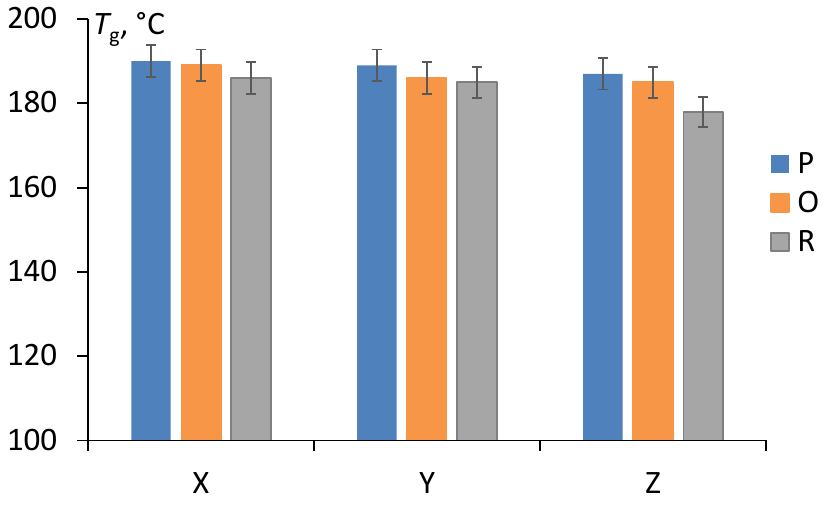
Figure 8. The glass transition temperature of Ultem samples cooled in the printer (P), oven (O), and at room temperature (R) and printed in X, Y and Z directions.